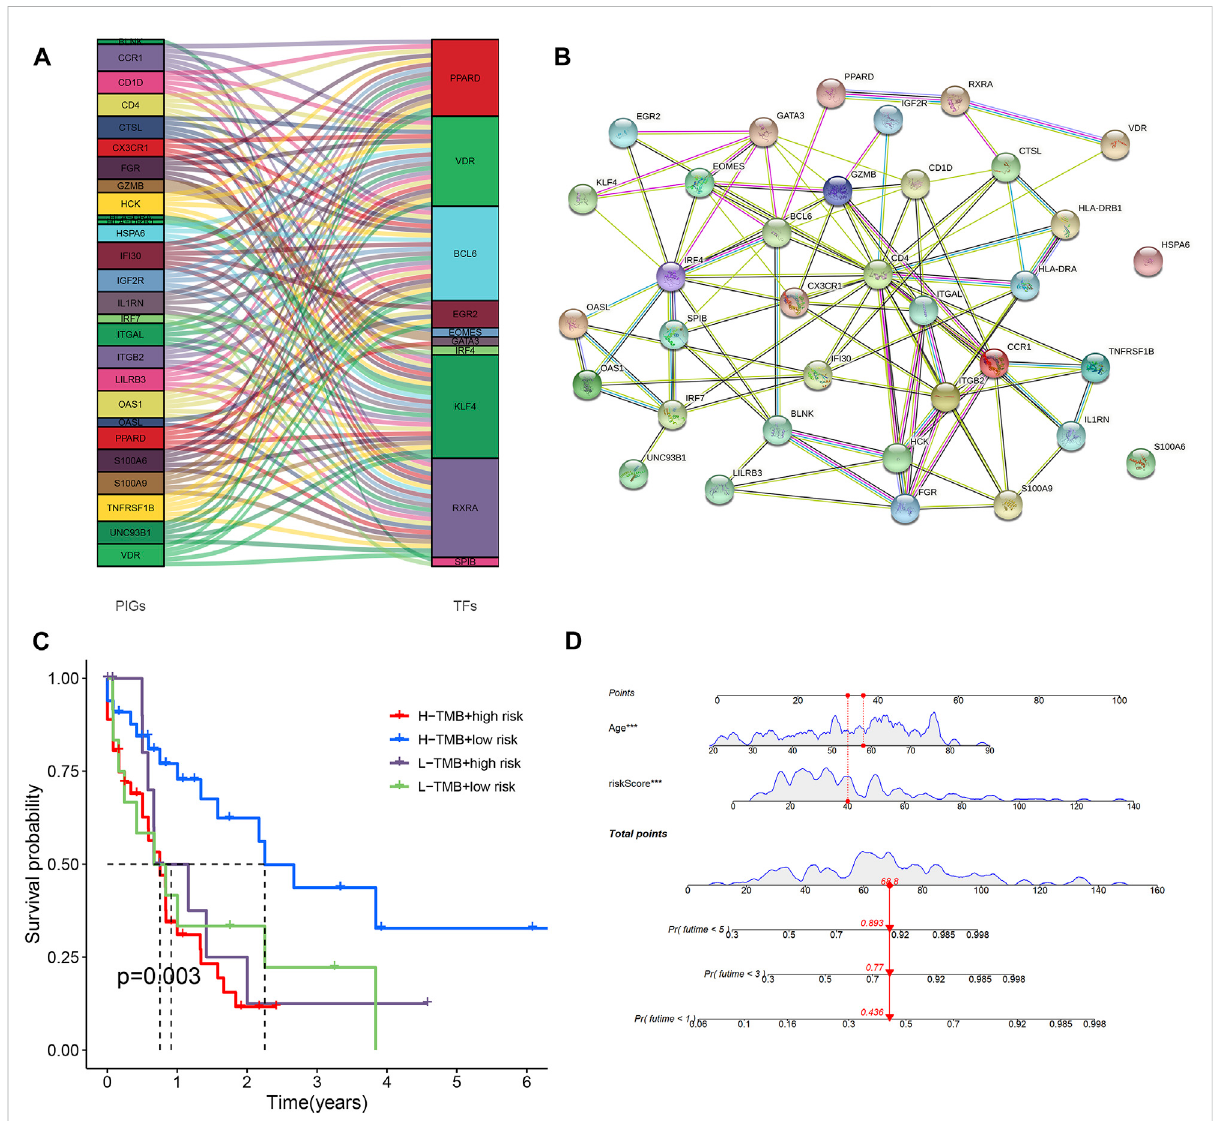
FIGURE 6 Predictive nomogram and PPI network. (A) Analysis of co-expressed of transcription factors and immune genes. (B) PPI networks of transcription factors and immune genes. (C) Comparison of survival rates for different TMB and different risk levels. (D) All clinical indicators were included in the